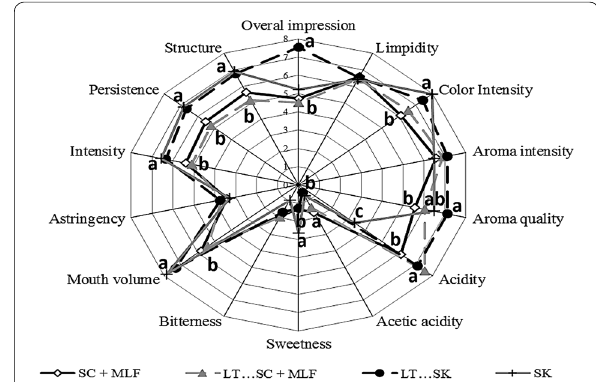
Fig. 3 Results of the sensory analysis of bottled wines from different fermentation processes of Saccharomyces cerevisiae 87 alone (SC), sequential fermentation with Saccharomyces cerevisiae 87 and L. thermotolerans CONCERTO ™ (LT…SC), sequential fermentation with S. pombe V2 and L. thermotolerans CONCERTO ™ (LT…SK), S. pombe V2 alone (SK), and fermentations after malolactic fermentation with Oenococcus oeni 217 ( +